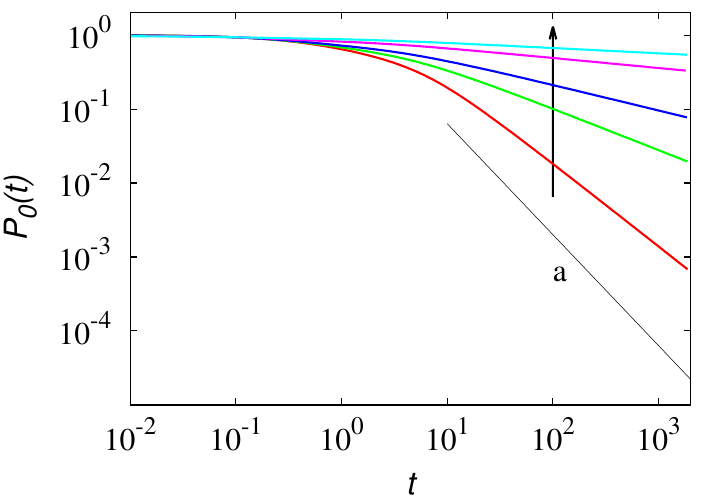
Figure 10. P 0 ( t ) for the counting process described by Equation (52) with ξ = 1.5, µ − = 0.3 at different µ + . The arrow indicates increasing values of µ + = 0.1, 0.5, 1, 3, 6. Solid line (a) represents P 0 ( t ) ∼ t − ξ .